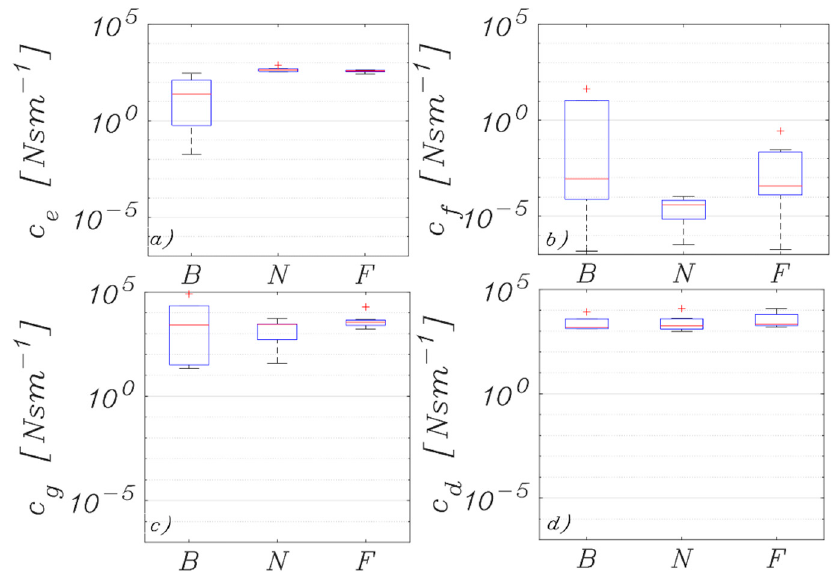
(cid:3033) ), but a trend is not clear for either parameter. The toe damping ( was found to vary with several orders of magnitude with median values 𝑐 (cid:3034)(cid:3003) = 2.5 × 10 3